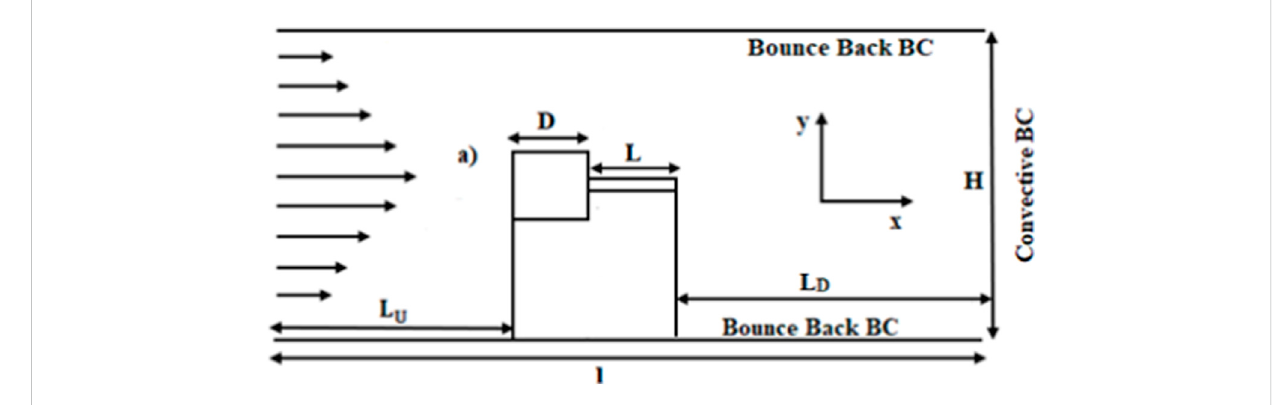
FIGURE 2 Schematic fl ow diagram.